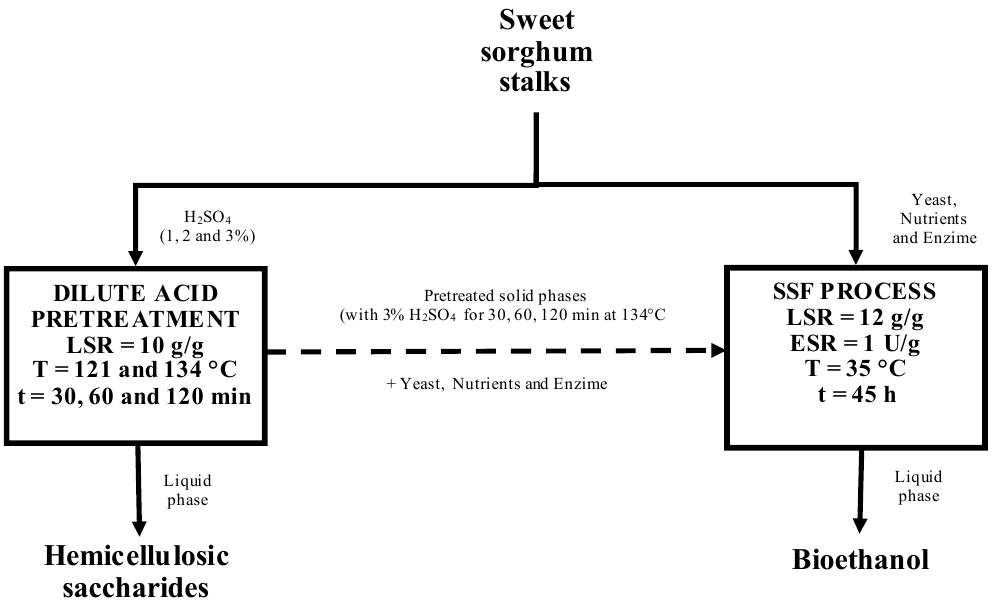
Figure 1. Scheme of the overall process considered in this work for the production of hemicellulosic saccharides from SSS and bioethanol from untreated SSS and selected pretreated solid phases (with 3% H 2 SO 4 for 30, 60 and 120 min at 134 °C). SSF, Simultaneous Saccharification and Fermentation; LSR, liquid to solid ratio; ESR, enzyme to substrate ratio.